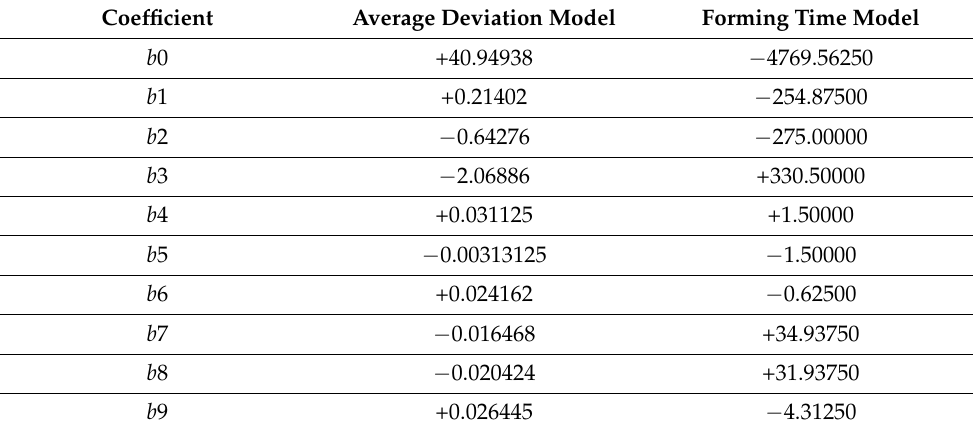
Table 3. Coefficients of the response surface models of the average deviation and forming time.